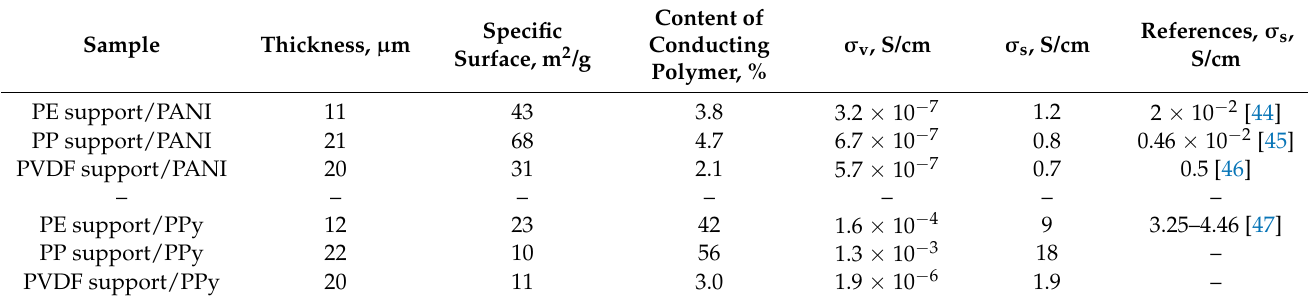
Figure 5. SEM micrographs (surface) of porous support ( a ), composites (porous support/PANI coating) ( b ), and (porous support/PPy coating) ( c ).